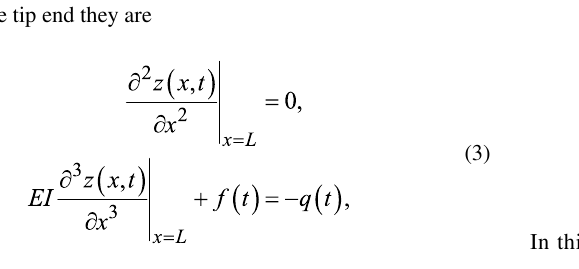
and at the tip end they